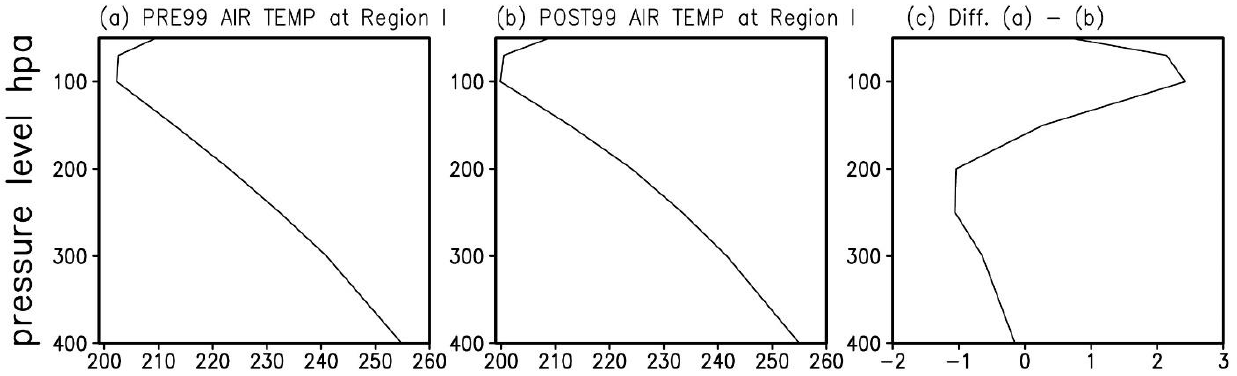
Figure 2. MJ (250 hPa–100 hPa) air temperature over Region I for ( a ) PRE99 and ( b ) POST99. ( c ) The difference between ( a ) and ( b ), or ( a ) - ( b ).